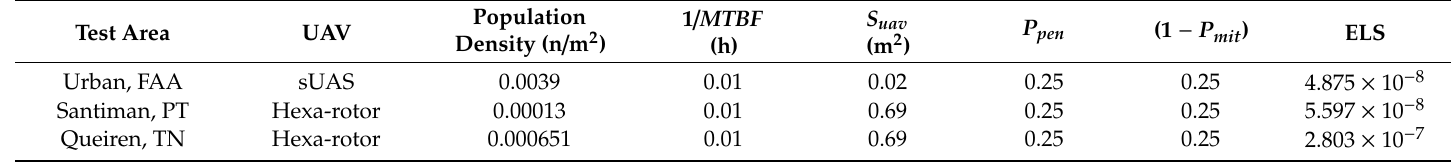
Table 2. Comparison of the expected level of safety (ELS) for this study with the ground impact